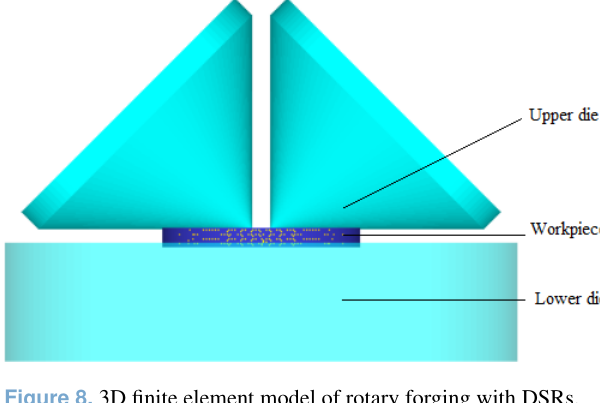
Figure 8. 3D finite element model of rotary forging with DSRs.